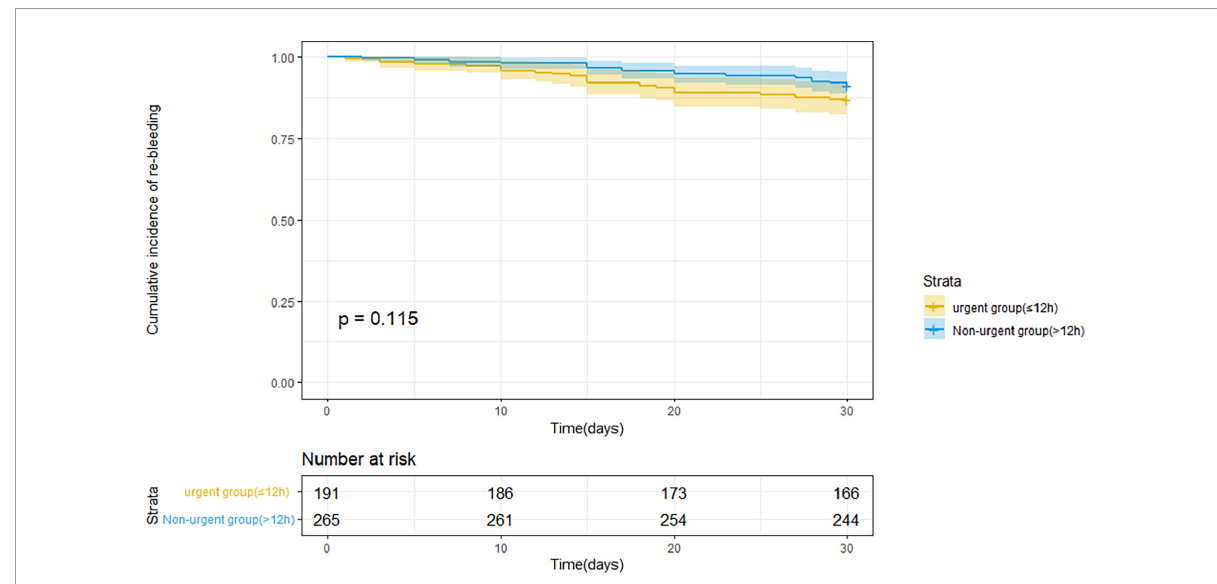
FIGURE1 Kaplan–Meier estimates of 30 days rebleeding in patients with acute variceal bleeding before propensity score